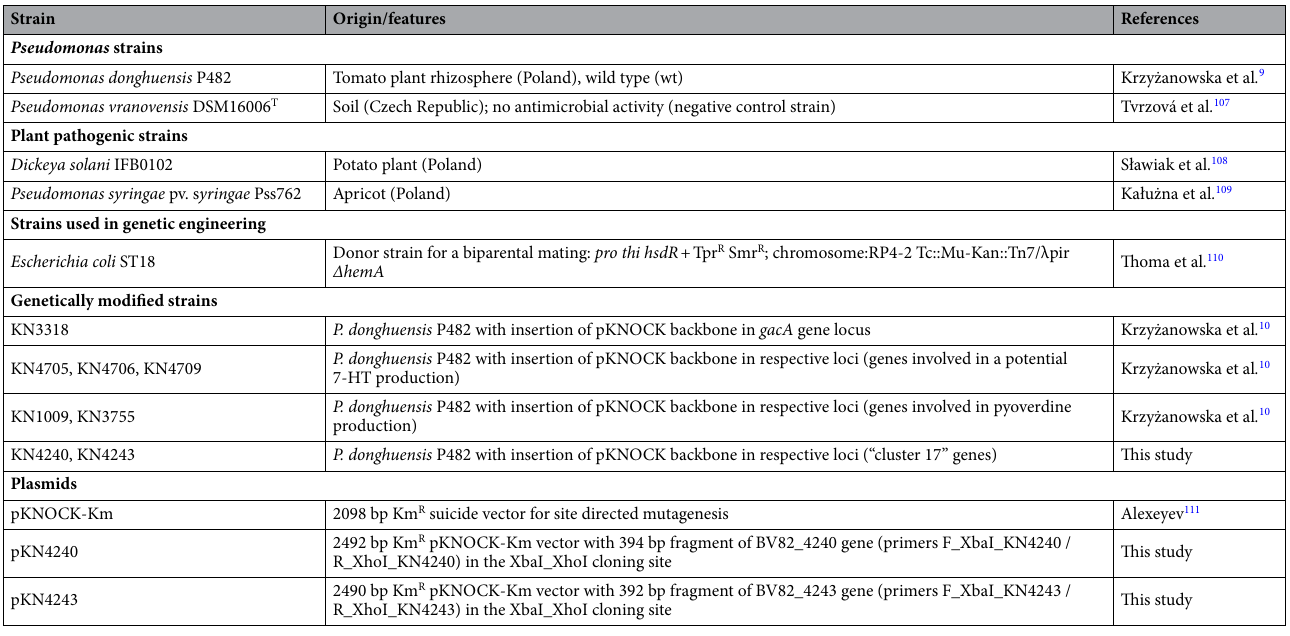
Table 4. Bacterial strains and plasmids used in the